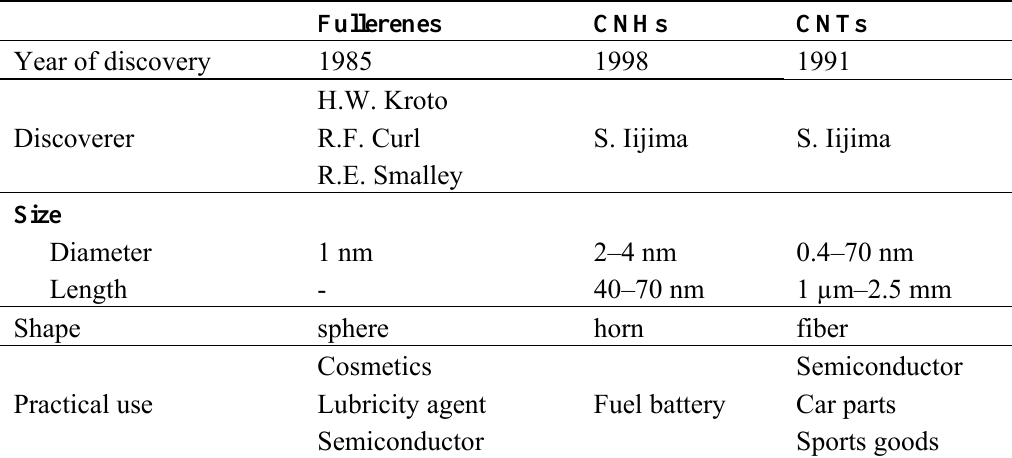
Table 1. Basic physicality of carbon